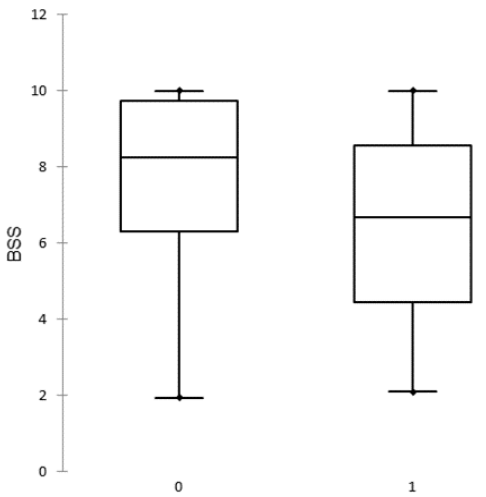
Figure 2. Distribution of biosecurity scores (BSS) in uninfected (0) and African swine fever outbreak (1) herds.